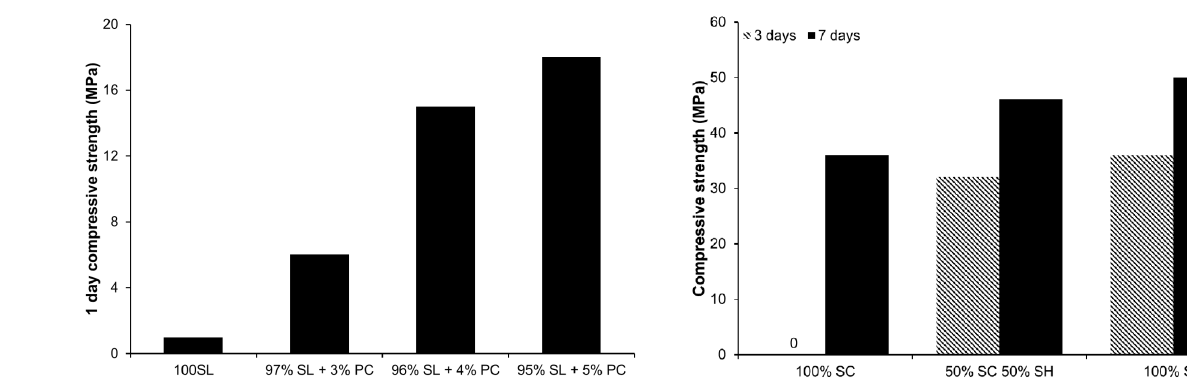
Figure 6: Effect of activator composition on early age compressive strength (adapted from [36])